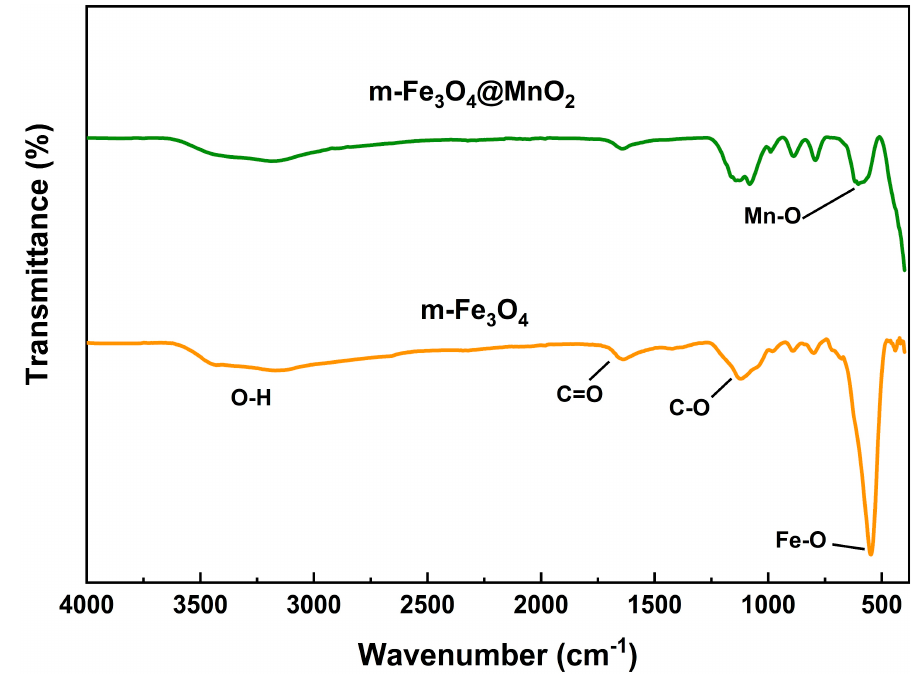
Figure 2. FTIR spectrum of m − Fe 3 O 4 and m − Fe 3 O 4 @MnO 2 nanocomposites.